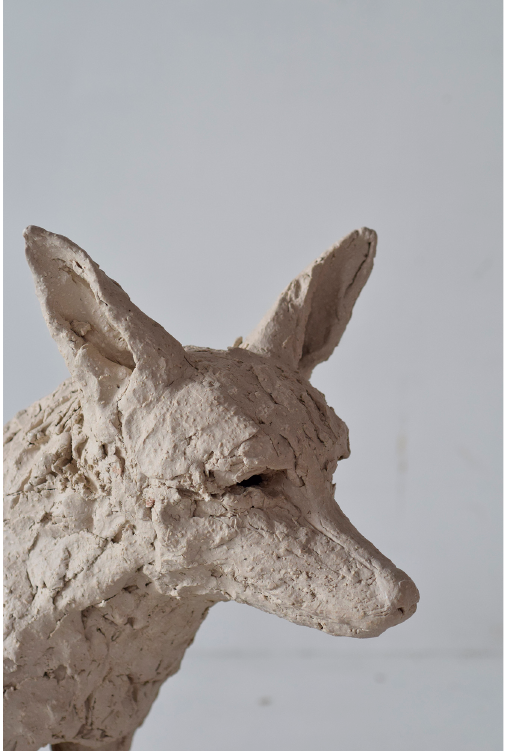
Figure 12. Sitting Cub (2020), Alternator Studio. Ceramic, 40 × 23 × 38 cm.